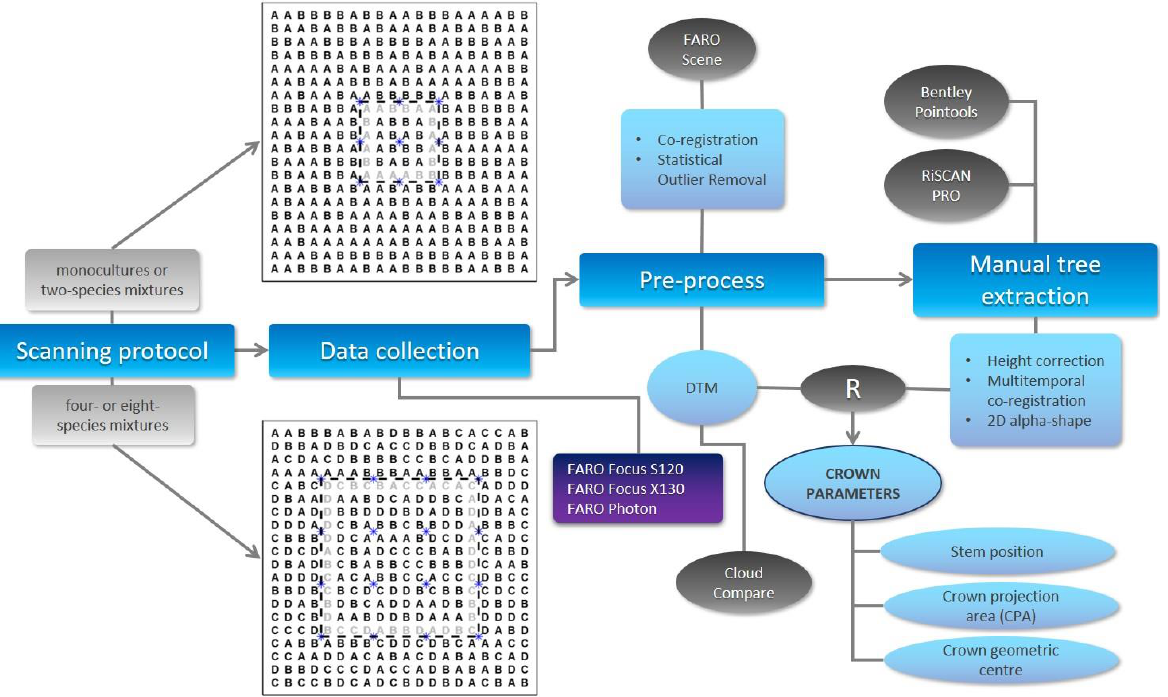
Figure 2. Workflow of data preparation. Schematic representation of the scanning protocol is adapted from Kunz et al. (2019, Figure S1) [13]. There, blue asterisks represent scanning positions, and letters indicate different tree species. Black circles show the used software, while the outcomes are in light blue circles. Main processes are in blue squares and the instruments used are in a purple square.